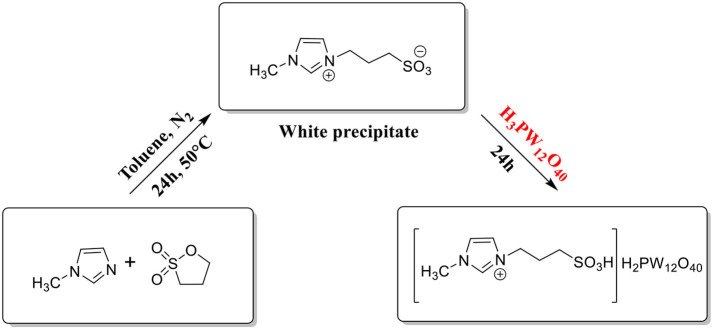
The synthetic routes to [C4H6N2(CH2)3SO3H]3PW12O40.